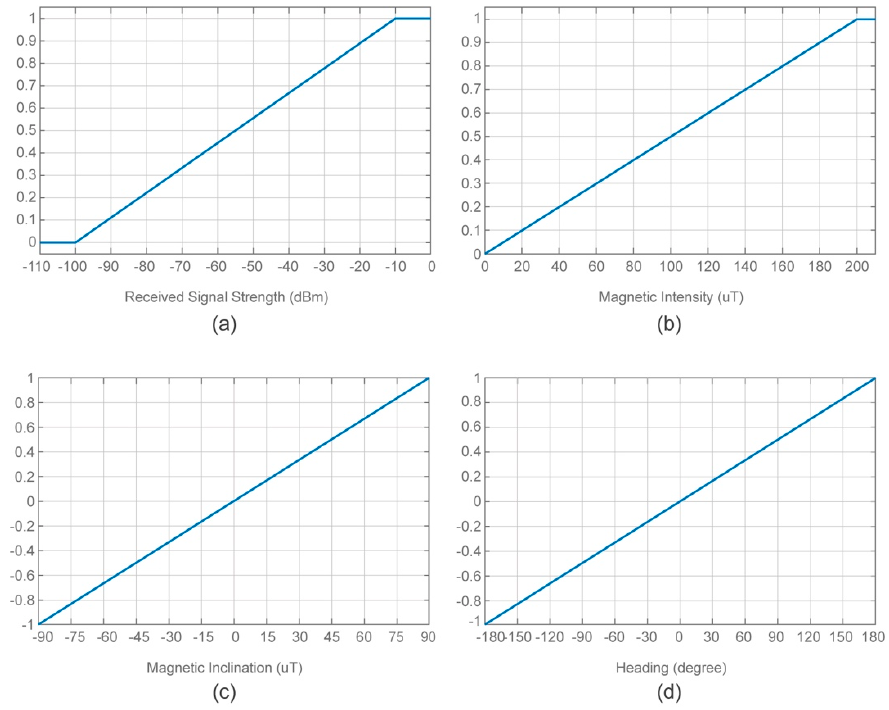
Figure 6. Translate functions of the input layer: ( a ) Wi-Fi signal strength; ( b ) geomagnetic intensity; ( c ) geomagnetic inclination; ( d ) moving direction.